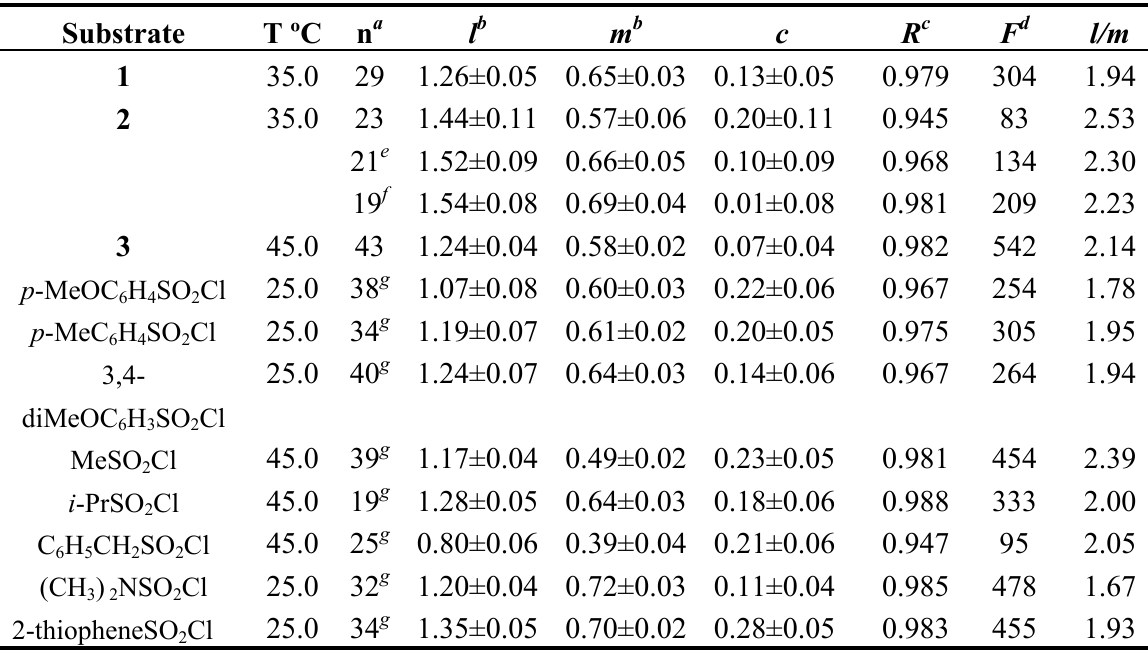
a Number of data points. b With associated standard error. c Multiple correlation coefficient. d F